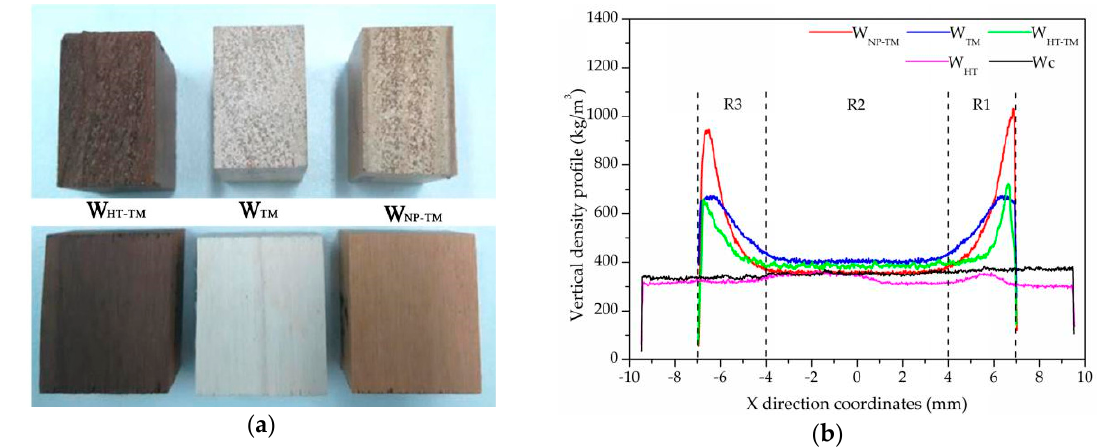
Figure 1. Photo ( a ) and vertical density profile (VDP) curves ( b ) of the selected samples.